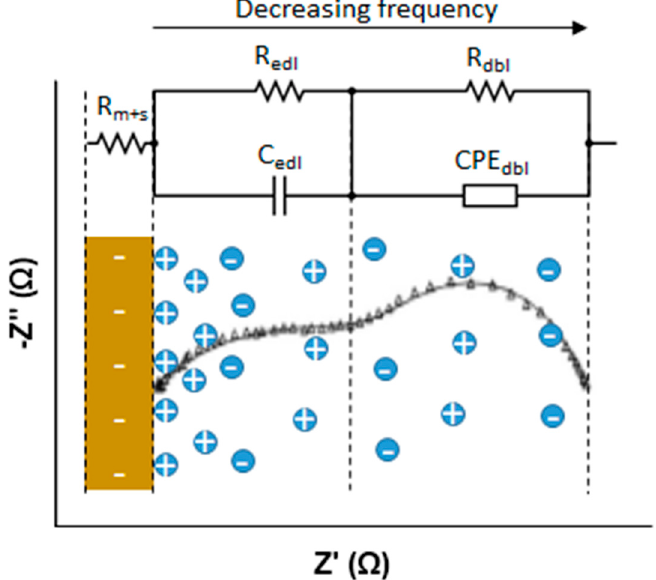
Figure 6. Equivalent circuit of a membrane-solution system impedance on the Nyquist diagram.